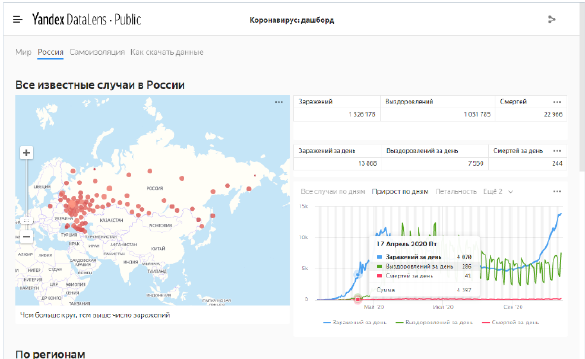
Figure 1. Web interface of the COVID-19 dashboard elaborated Figure 3. Proportion of the initial medical statistics data records by Johns Hopkins University. and geocoded data records, by administrative districts.